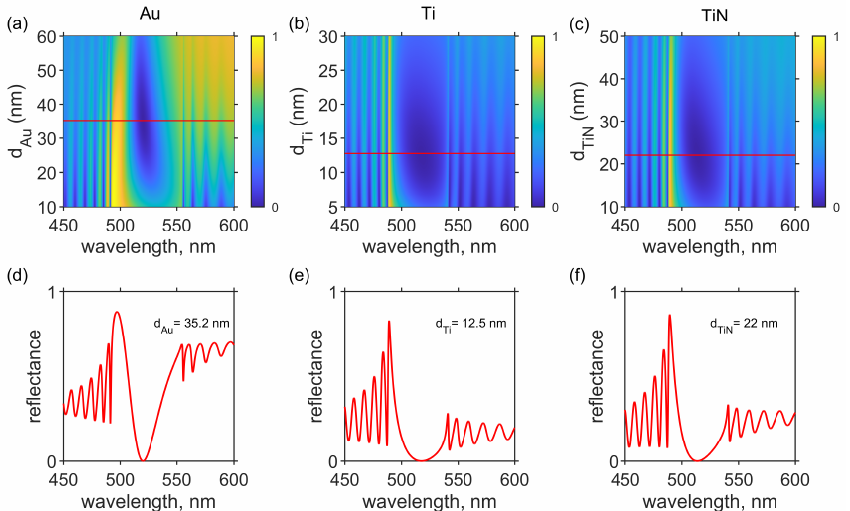
Figure 4. Reflectance spectra of the structures consisting of the PC conjugated with ( a ) the gold, ( b ) titanium, and ( c ) titanium nitride film of different thicknesses. ( d – f ) Reflectance spectra of the corresponding structures under the condition of critical coupling of the incident field with the